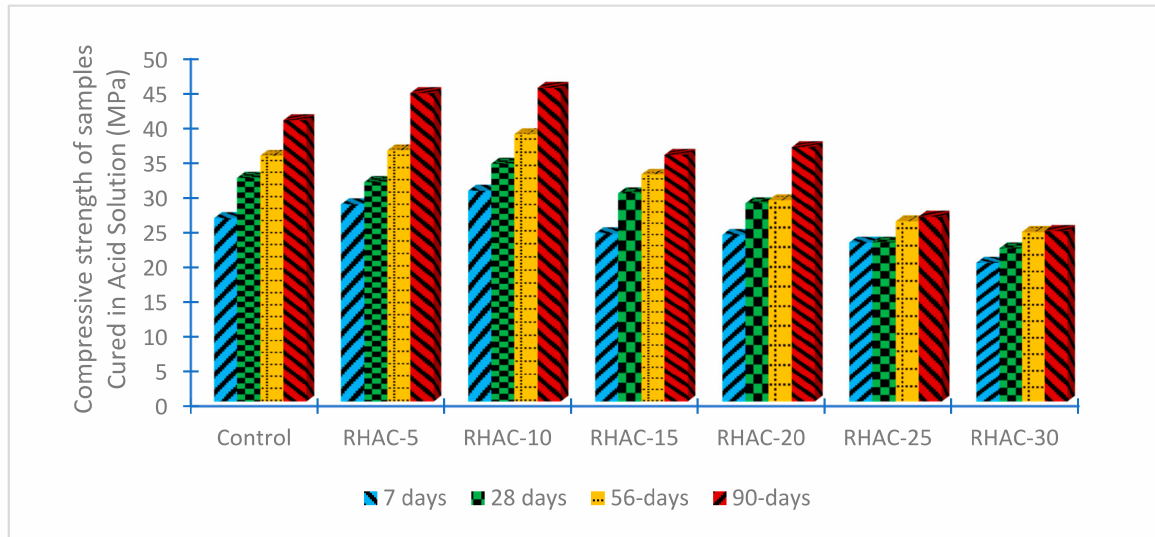
Figure 15. Compressive strength of RHA blended HPC cured in an acid